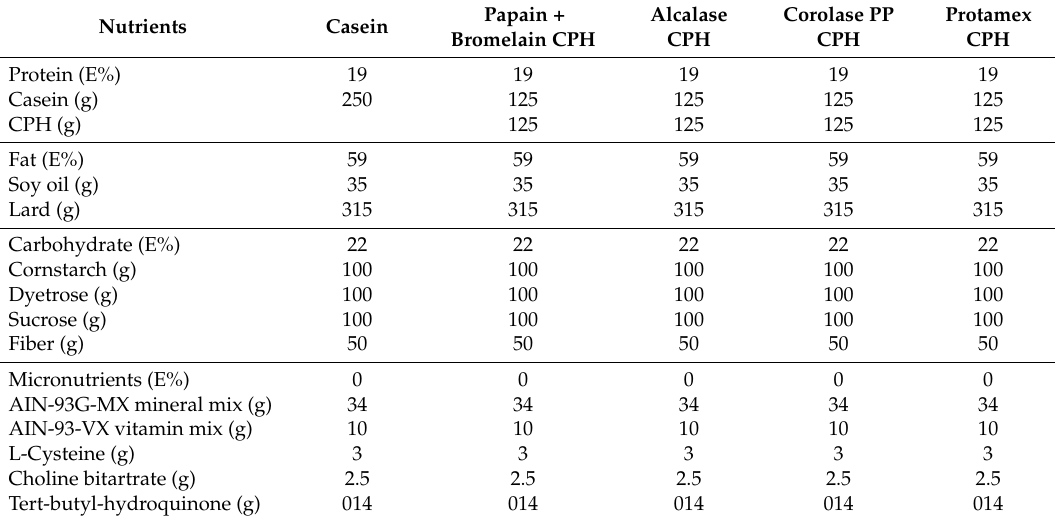
Table 1. Nutrient composition of the diets in energy % (E%) and weight